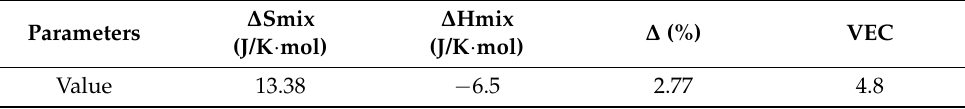
Table 5. Thermodynamic parameters of TiAlMoNbW system.